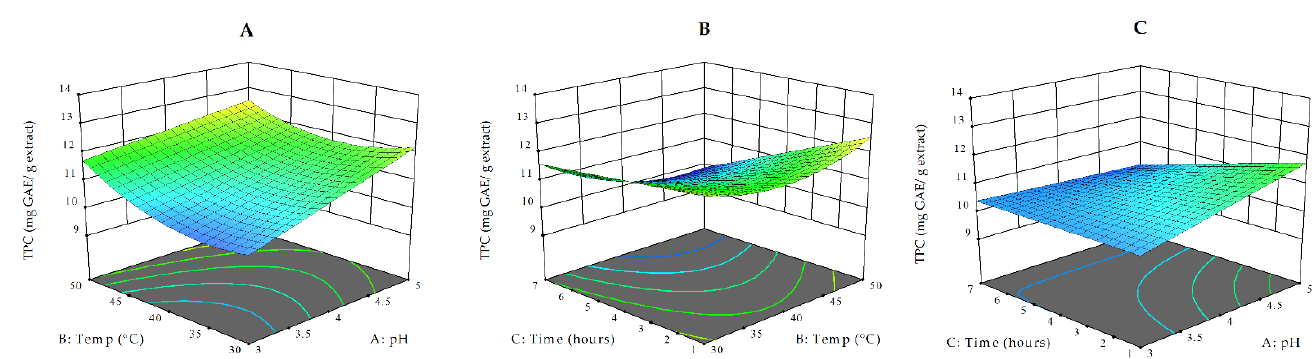
Figure 3. 3D response surface plots for TPC as a function of temperature and pH (at a constant time of 4 h and at an enzyme concentration of 6 AU/g) ( A ), temperature and time (at a constant pH of 4 and at an enzyme concentration of 6 AU/g) ( B ), and extraction time and pH (at a constant temperature of 40 °C and at an enzyme concentration of 6 AU/g) ( C ).